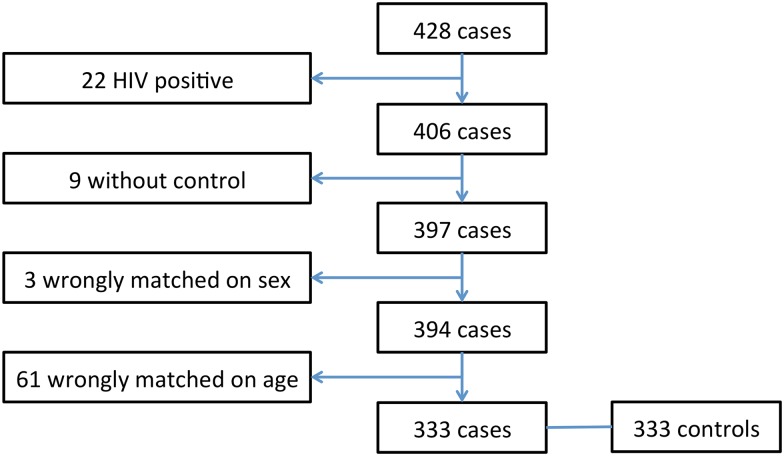
Study flow chart.